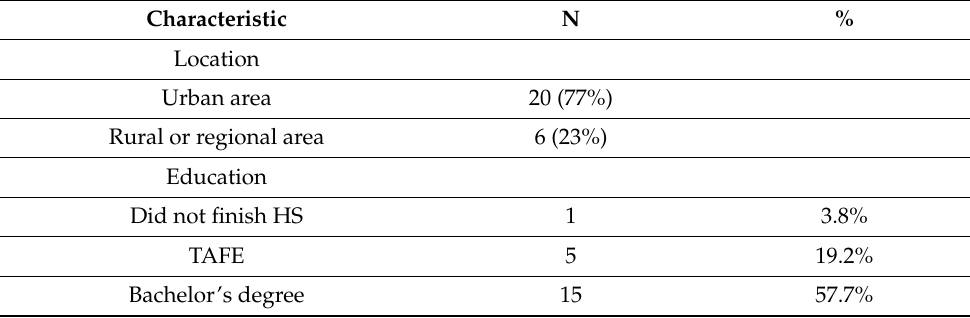
Table 1. Demographics of